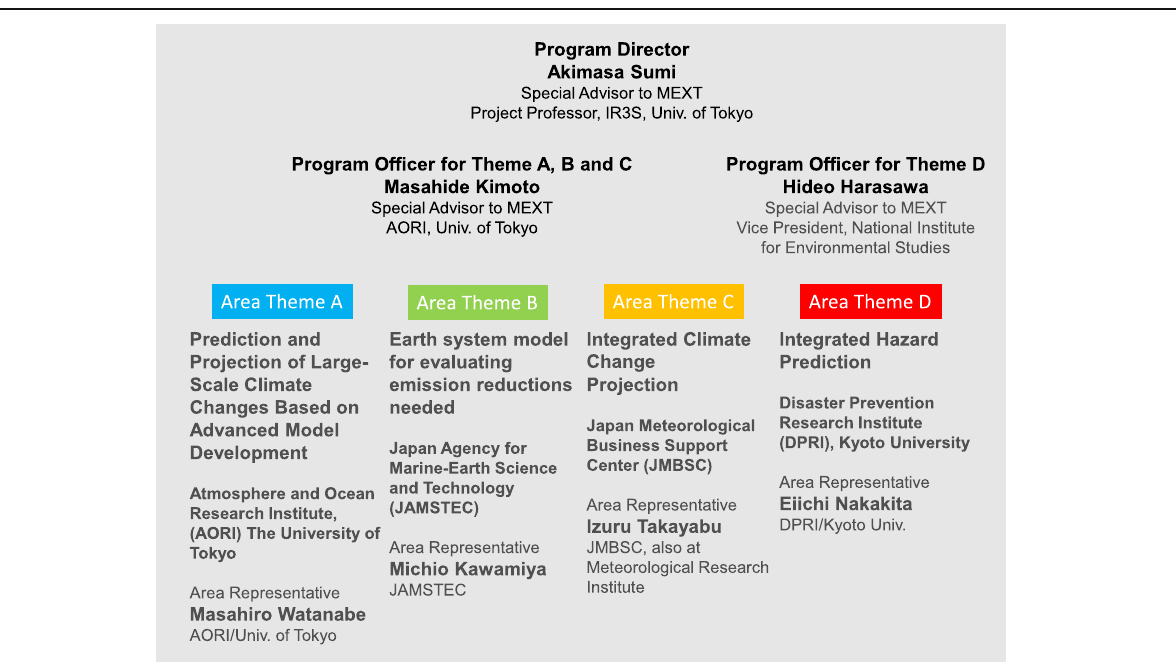
Fig. 1 Structure of the TOUGOU program. Titles are as of April 2017, when the TOUGOU program has launched. Modified from TOUGOU